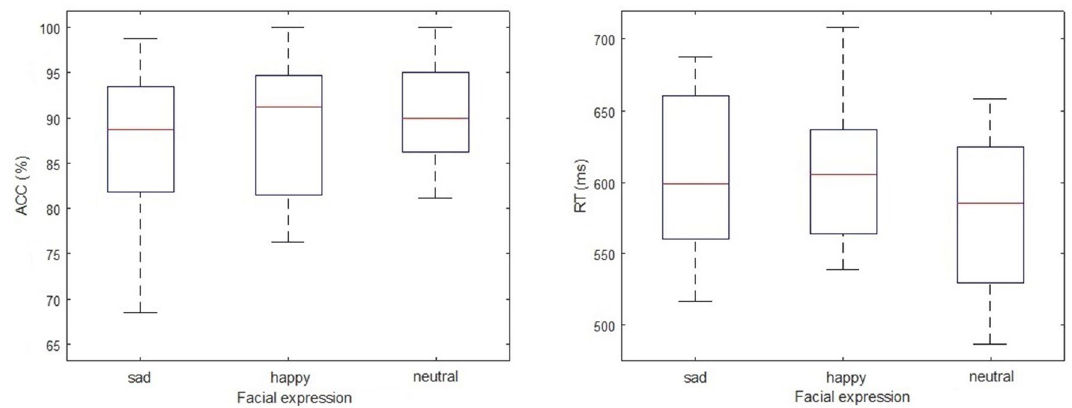
Figure 2. Boxplots of ACC and RT in each condition in EST. The top and bottom lines of the plot indicates the maximum and minimum values, the top and bottom lines of the box indicates the 75th and 25th percentile values, and the red line indicates the median